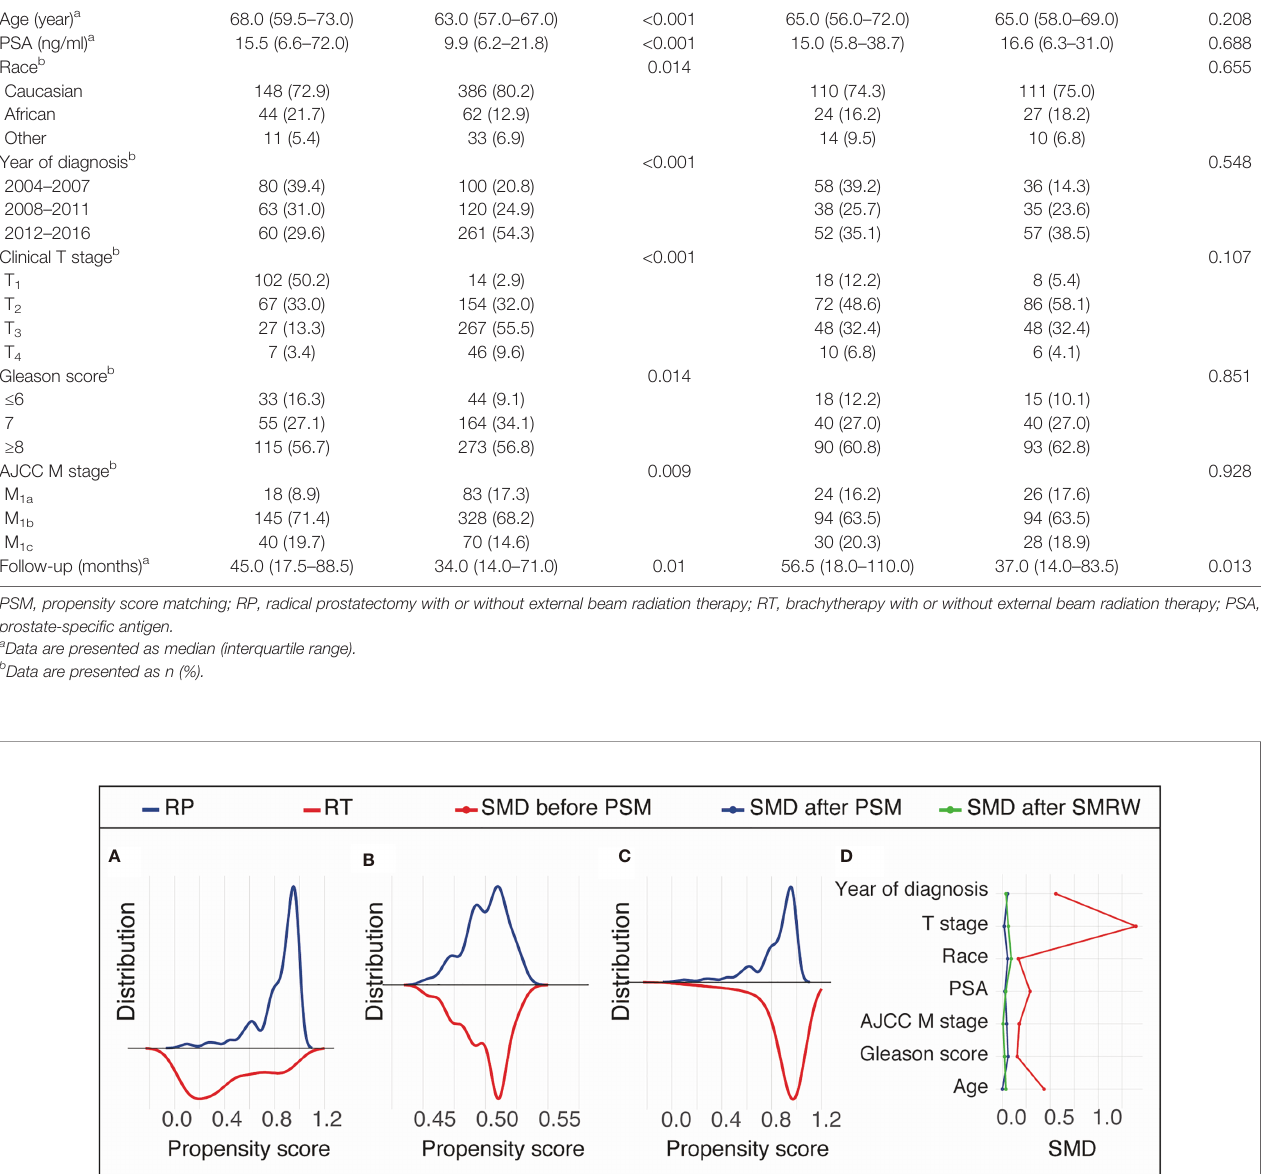
TABLE 1 | Baseline demographic and clinicopathologic characteristics sorted by local treatments before and after PSM. Before PSM After PSM RT ( n = 203) RP ( n = 481) p -value RT ( n = 148) RP ( n = 148) p -value